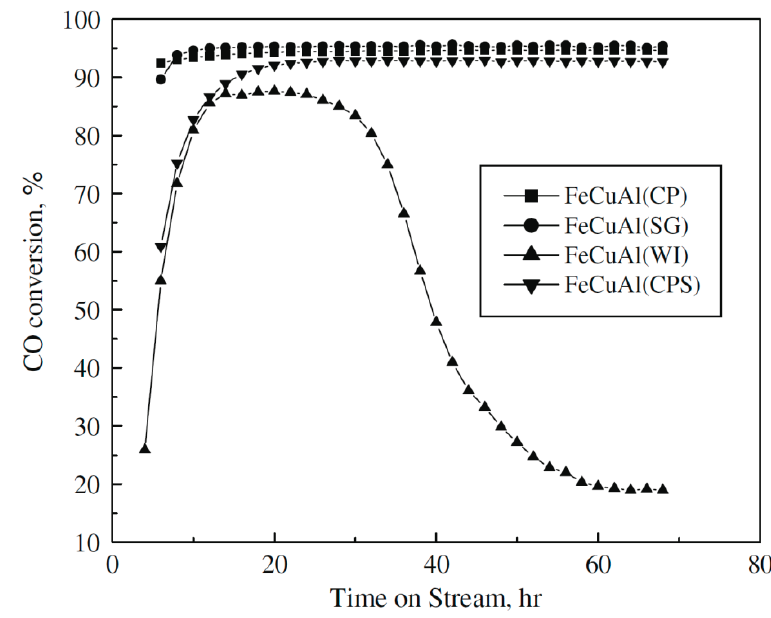
Figure 22. Activity variation of Fe–Cu–Al catalysts with time-on-stream [114].